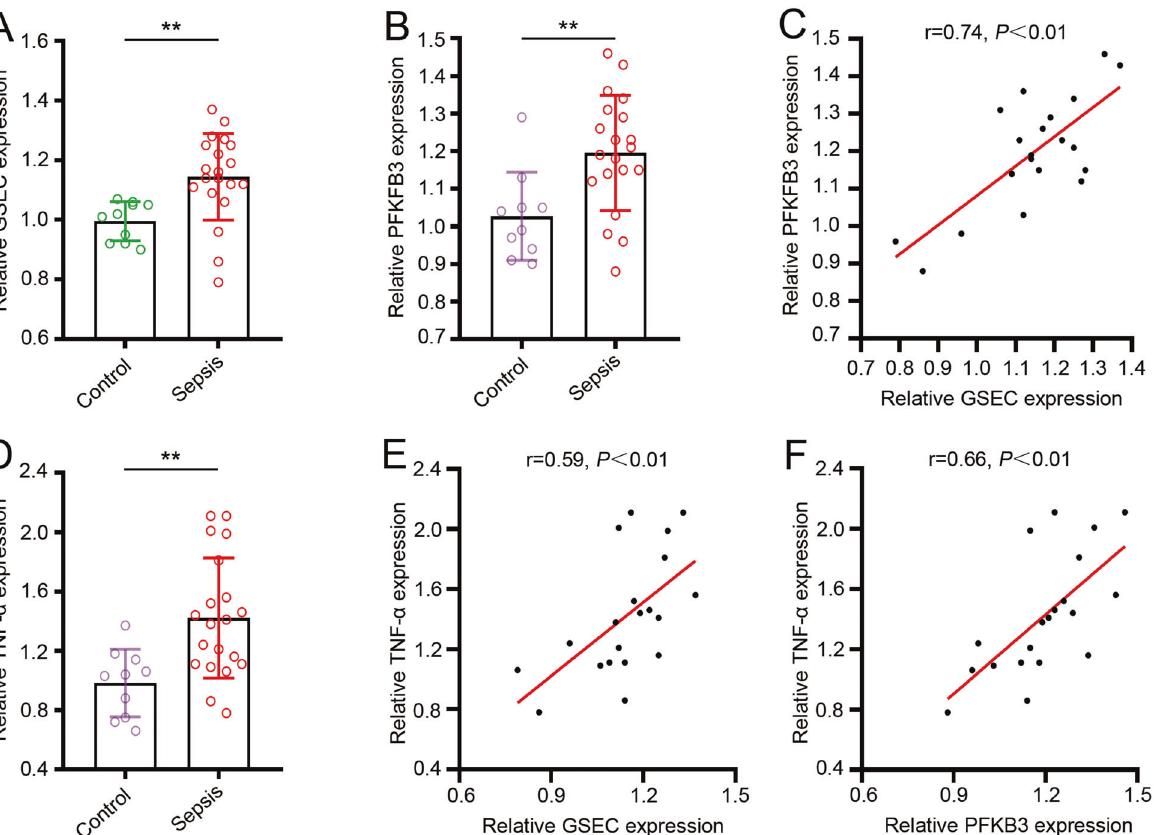
Fig. 3 Expression and correlation of GSEC, PFKFB3, and in fl ammatory cytokine genes in septic neutrophils. A Expression of GSEC in septic neutrophils. B Expression of PFKFB3 in septic neutrophils. C Correlation of GSEC and PFKFB3 genes in septic neutrophils. D Expression of TNF- α in septic neutrophils. E Correlation of GSEC and TNF- α in septic neutrophils. F Correlation of PFKFB3 and TNF- α in septic neutrophils. For each group: septic patients, n = 20; healthy volunteers, n = 10, three independent experiments. Statistics were calculated using Student ’ s t -test ( A , B , D ) or Pearson ’ s analysis ( C , E , F